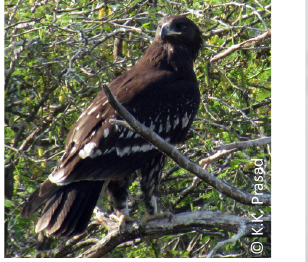
Image 18. Greater Spotted Eagle Aquila clanga